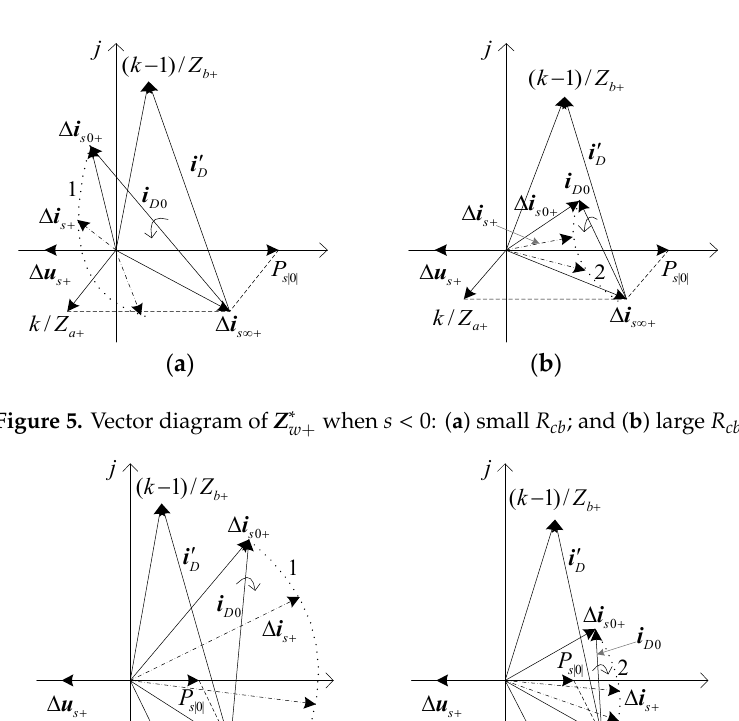
Z Z  ; and ( b ) b  . ∗ with di ff erent s can be plotted as w + ∗ can be analyzed in w +